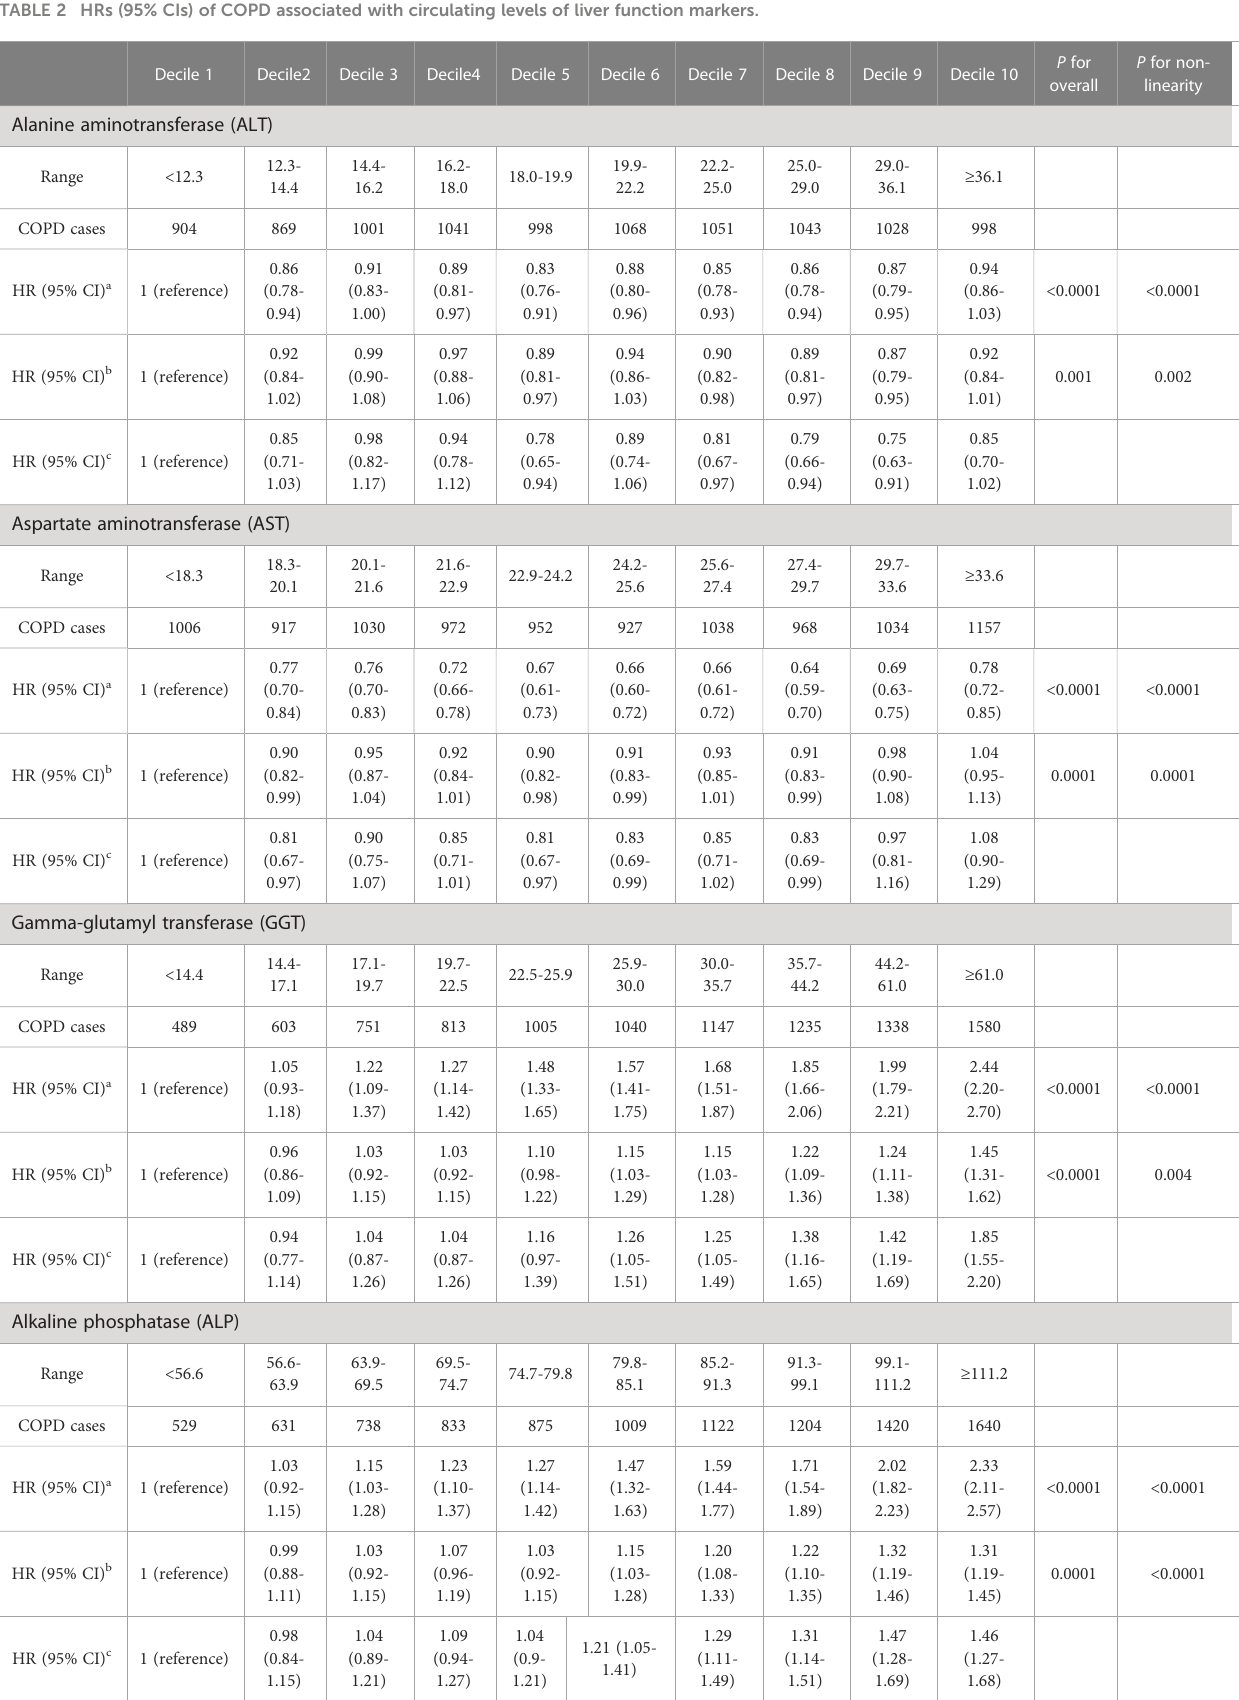
TABLE 2 HRs (95% CIs) of COPD associated with circulating levels of liver function markers. Decile 1 Decile2 Decile 3